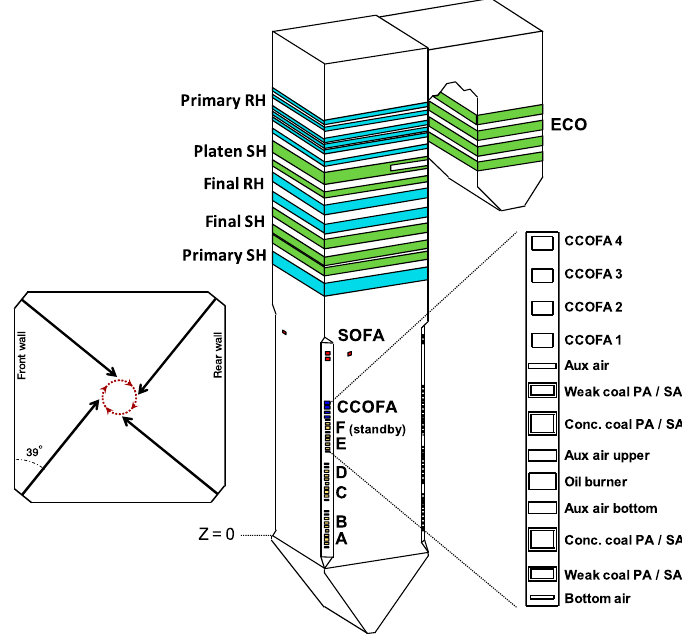
Figure 1. Schematic of the 500 MWe coal-fired tangential-firing (TF) boiler.